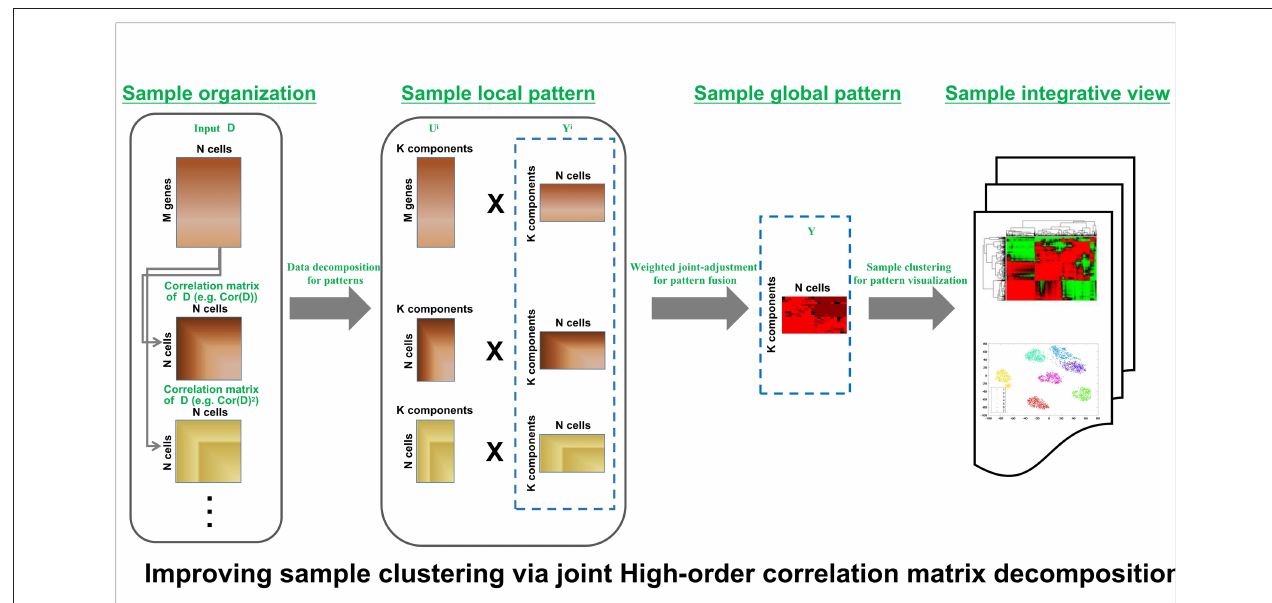
FIGURE 1 | HCI framework of high-order correction matrices based on pattern fusion analysis Overview of single-cell clustering with HCI framework (see section Materials and